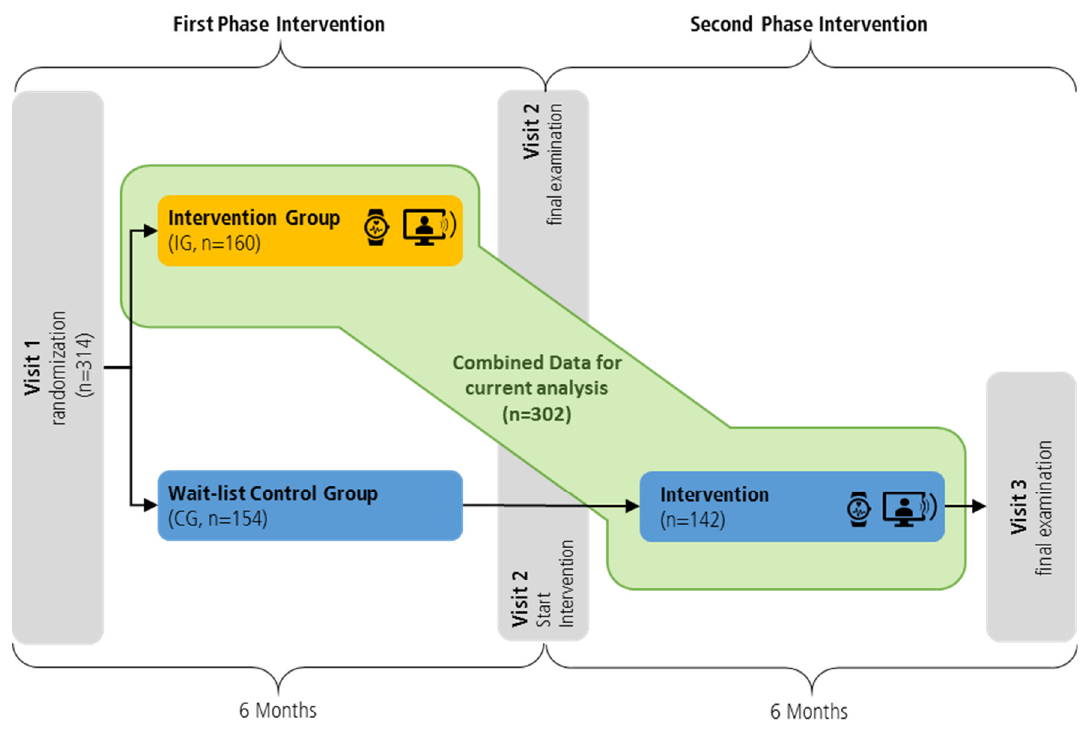
Figure 1. Study design and randomization.